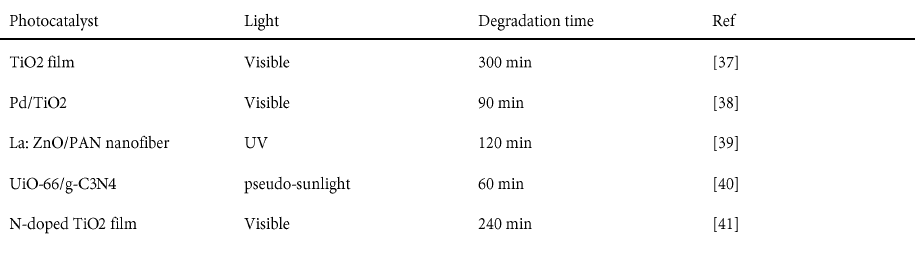
O sample with reported 2